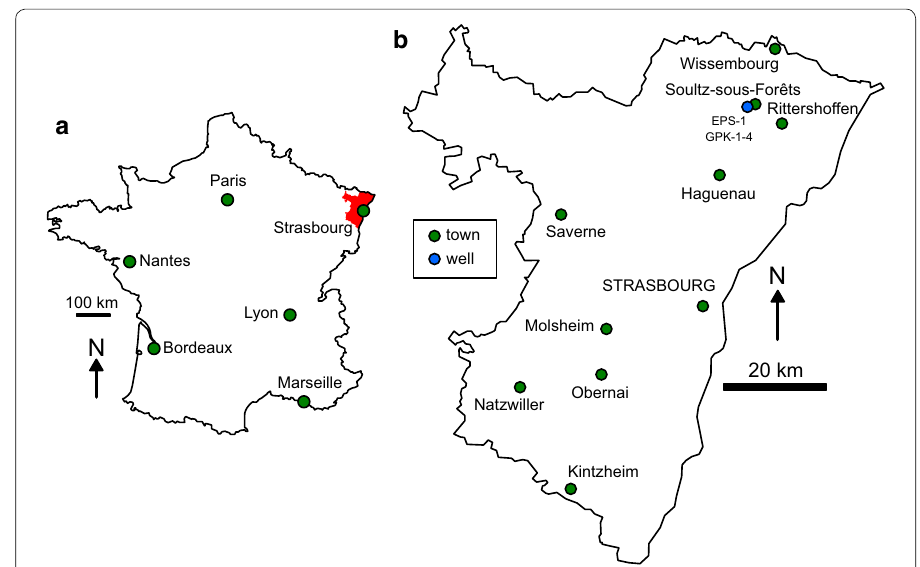
Fig. 1 a Map of France showing the location of the Bas-Rhin department of Alsace (in red). b Map of the Bas-Rhin department of Alsace (shown in red in a ) showing the location of the major cities/towns in Alsace, including Soultz-sous-Forêts and Rittershoffen (green circles), and the wells EPS-1 and GPK-1-4 at Soultz-sous-Forêts (blue